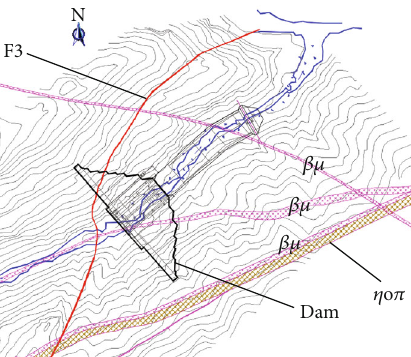
Figure 2: Plan view for engineering geology at lower reservoir of the power